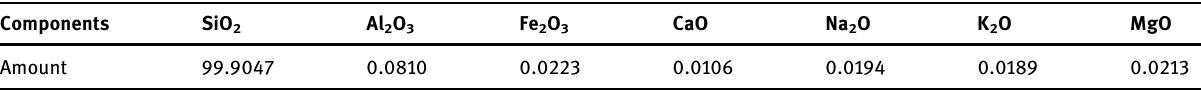
Table 2: The chemical composition of concentrate samples by XRF ( % ) Components SiO 2 Al 2 O 3 Fe 2 O 3 CaO Na 2 O K 2 O MgO Amount